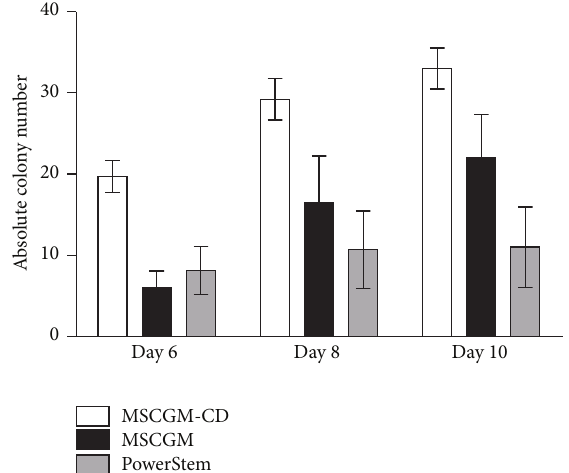
Figure 2: Quantity of hMSC colonies. Quantity of hMSC colonies at days 6, 8, and 10 grown in MSCGM (black), MSCGM-CD (white), and PowerStem (grey) growth medium, respectively. Data presented as mean ± SEM ( 𝑛 = 10 ). Unpaired two-tailed 𝑡 -test was performed for statistical analysis. Differences were not significant between groups.